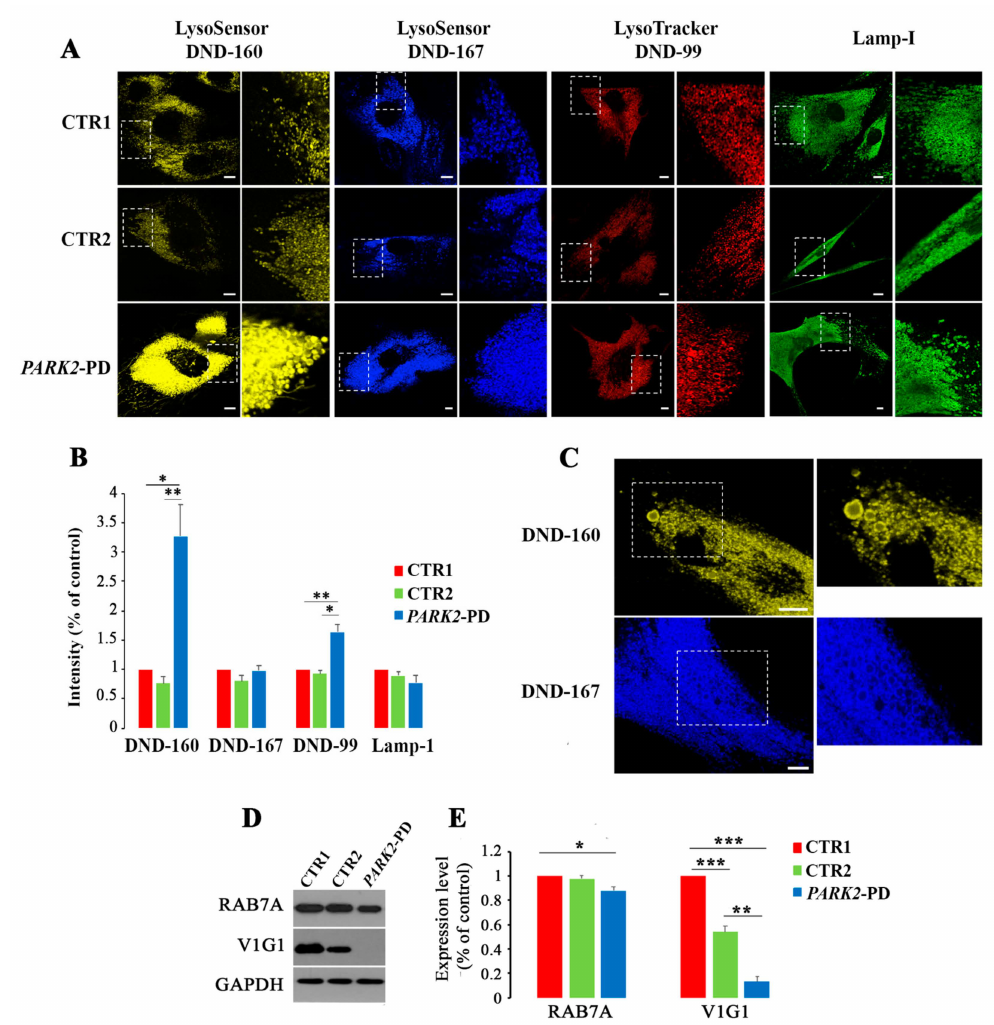
Figure 1. Alterations of late endocytic compartments in PARK2 -PD cells. ( A ) Cells were labeled live with LysoSensor DND-160 (yellow), with LysoSensor DND-167 (blue) and with Lysotracker Red DND-99 or were fixed and immunostained with anti-LAMP1 antibody (green). White dashed boxes indicate zoomed areas on the right. Scale bar: 10 µ m. ( B ) Immunofluorescence intensity was quantified by ImageJ software. Data represent the mean ± s.e.m. (three independent experiments, ≥ 20 cells). ( C ) Staining with LysoSensor DND-160 (yellow) and with LysoSensor DND-167 (blue) show enlarged lysosomes in PARK2 -PD cells. White dashed boxes indicate zoomed areas on the right. Scale bar: 10 µ m. ( D , E ) Relative protein abundance of RAB7A and ATP6V1G1 was assessed by western blotting and quantified by densitometry normalizing against GAPDH. Data represent the mean ± SE of at least three independent experiments (* p ≤ 0.05, ** p ≤ 0.01 *** p ≤